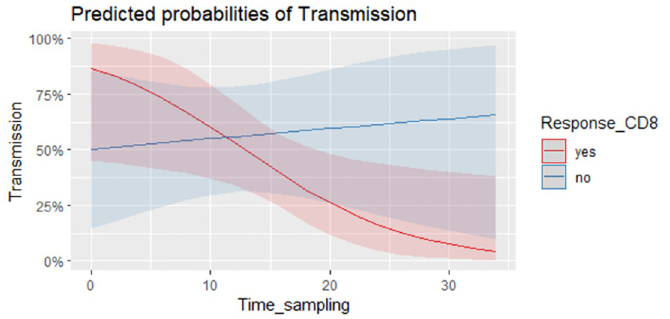
Fig 5. Interaction time–effect of CMV-CD8+IFN- γ lymphocytes. Model showing the time interval from infection to blood sampling against the predicted probability of CMV intrauterine transmission in women presenting a positive CD8 response (% of CD8-g-IFN producers above 0.1 in red) or not (in blue).